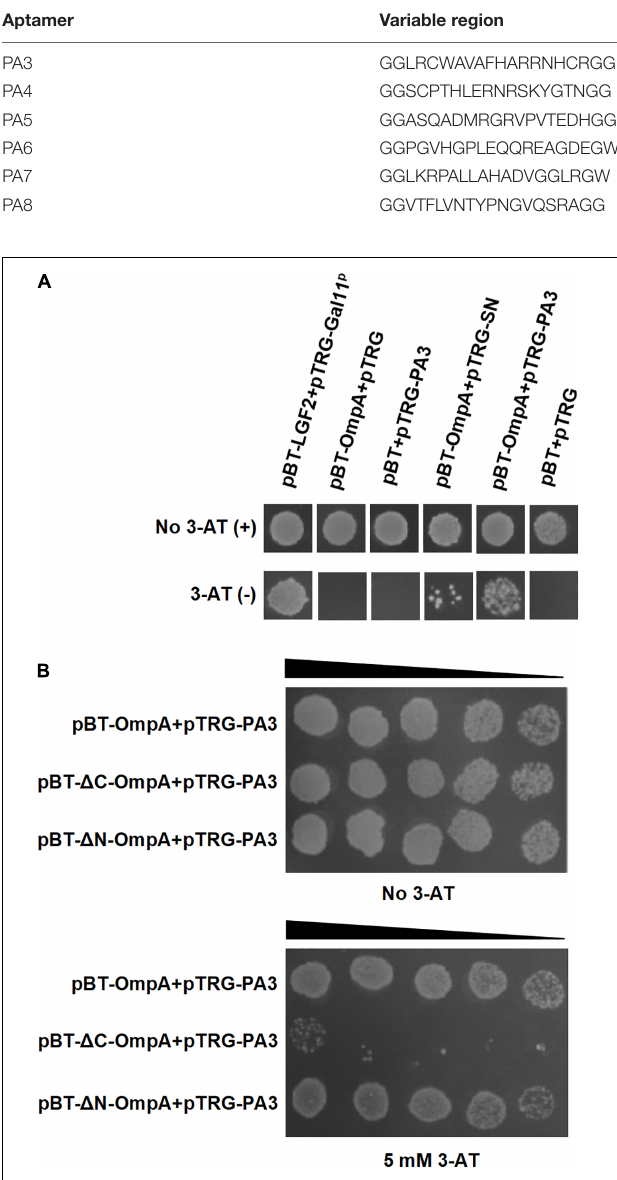
TABLE 1 | Sequences of peptide aptamers.